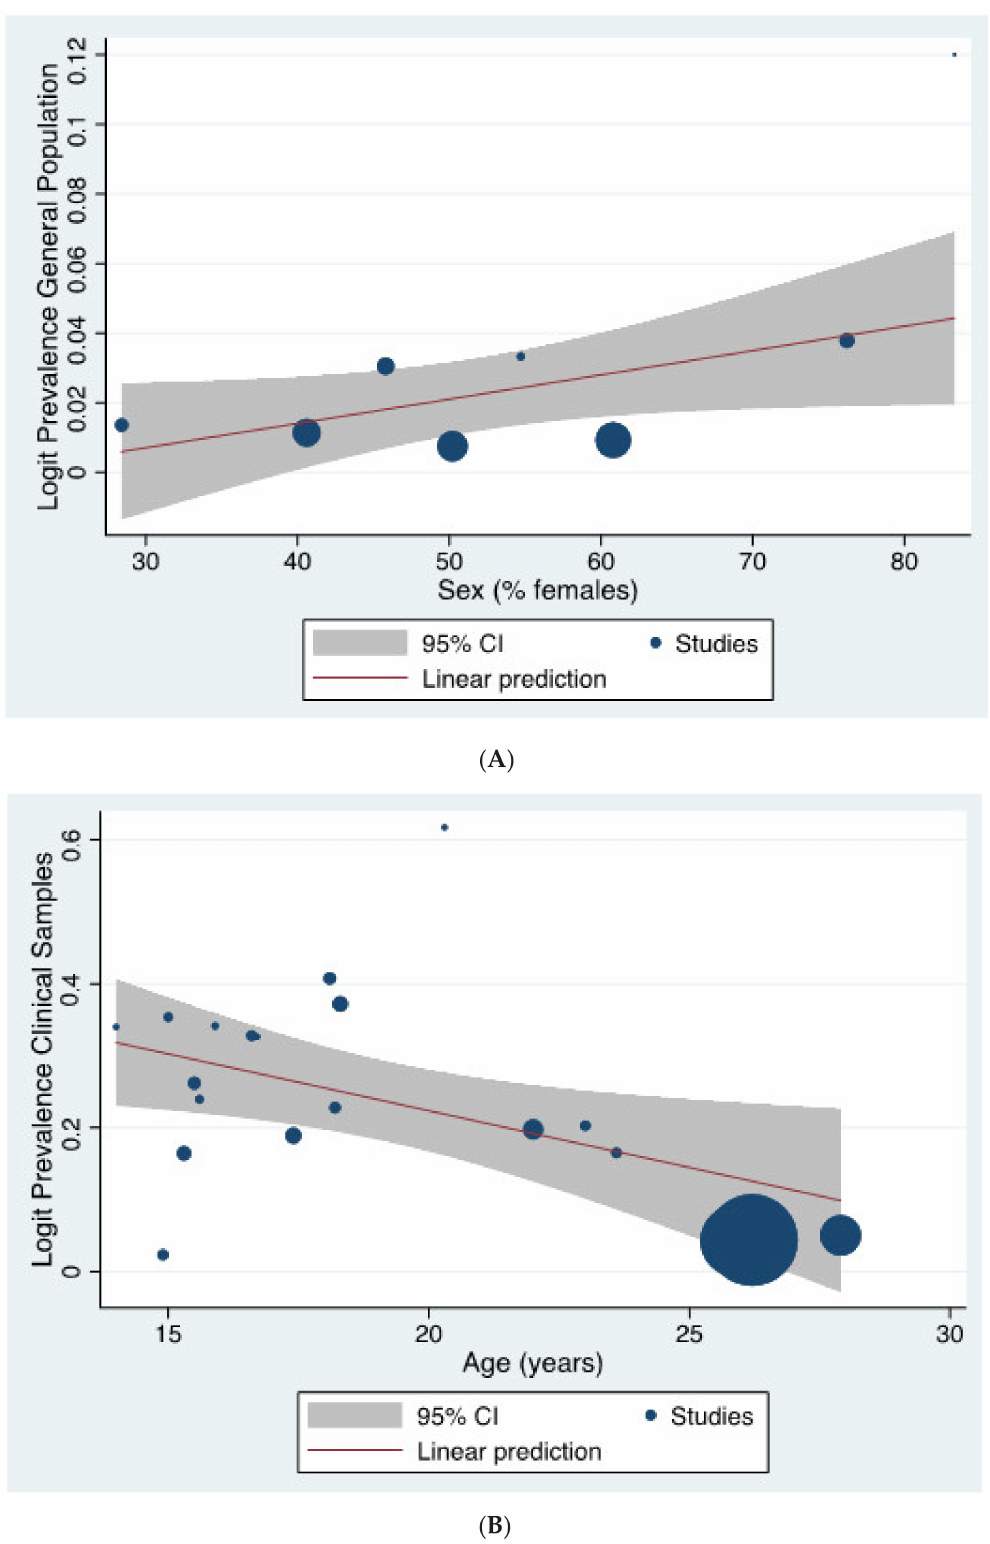
Figure 4. ( A ) Meta-regressions of the influence of sex (% female) on the prevalence of CHR-P in the General Population. A significant increase in the prevalence of CHR-P individuals with an increasing proportion of females ( β = 0.045, p = 0.041) was found in the general population. ( B ) Meta-regression of the influence of age on the prevalence of CHR-P in clinical samples. A significant decrease in the prevalence of CHR-P individuals with an increasing age ( β = − 0.160, p < 0.001) was found in clinical